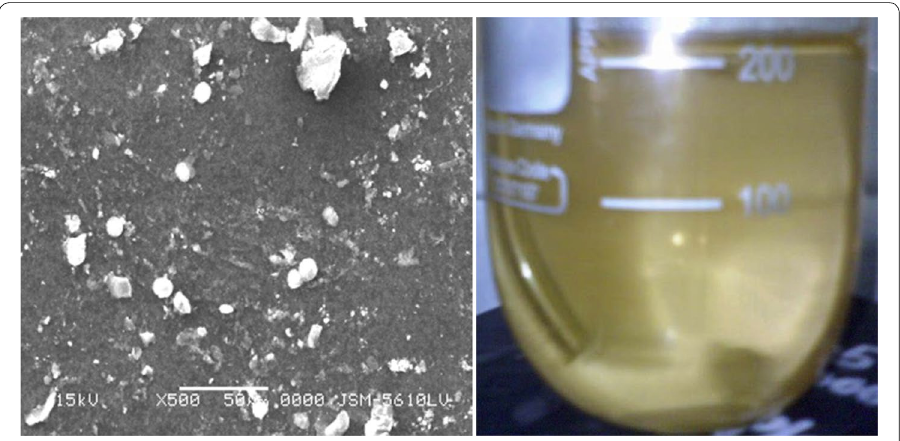
Fig. 1 Scanning electron microphotographs of copper nano